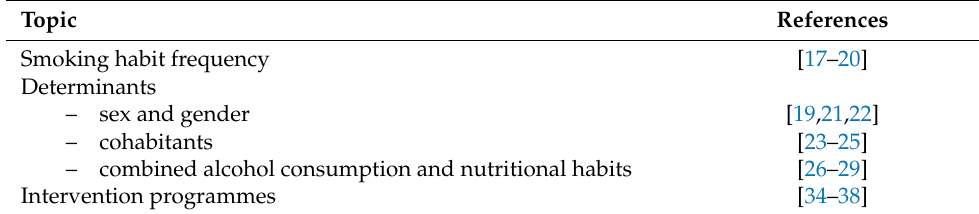
Table 3. Related work